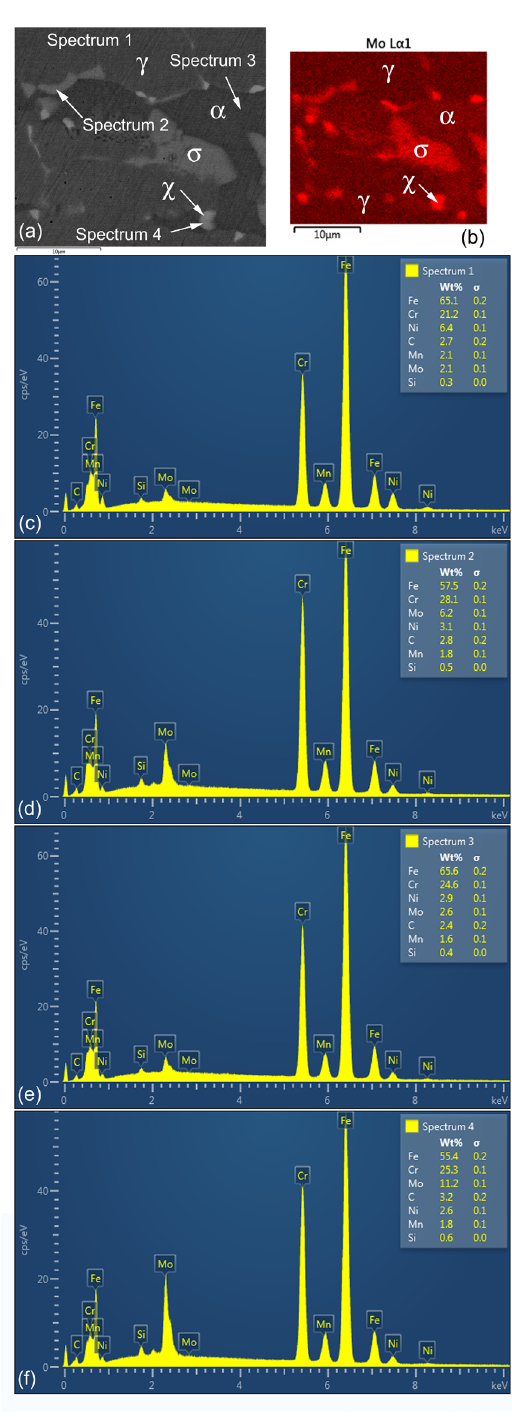
Figure 3. Map of chemical composition obtained by EDS for a sample submitted to 30 minutes isothermal heat treatment. (a) SEM micrograph analysis showing five different phases; (b) EDS spectrum 1: γ (austenite); (c) EDS spectrum 2: σ (sigma